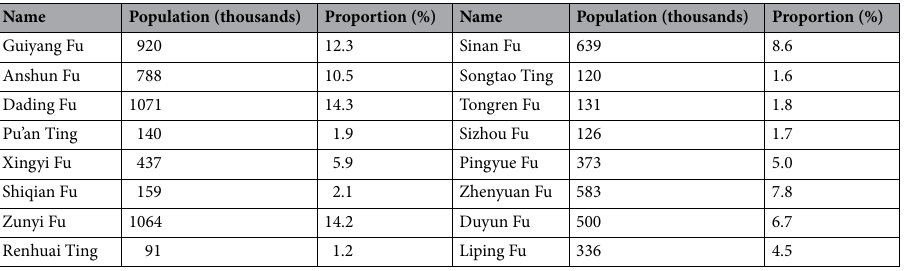
Table 1. Correction of population data.